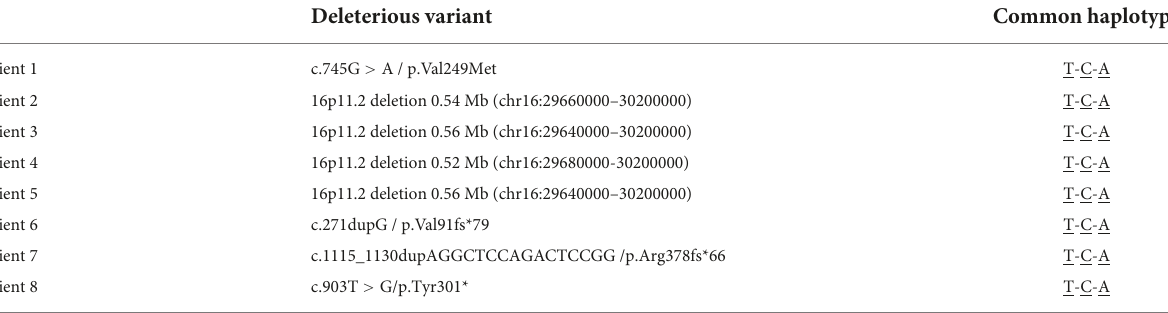
TABLE 1 The genotypes of patients.